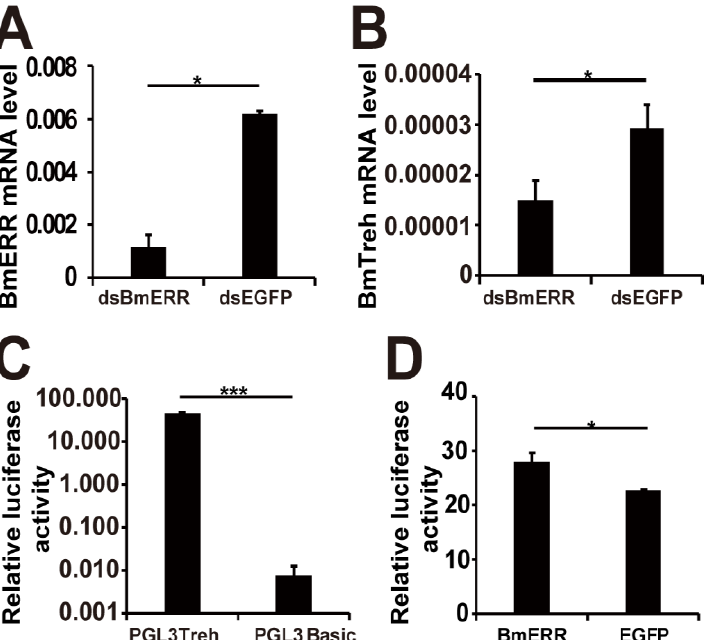
Figure 2. The expression of BmTreh is upregulated by BmERR in BmE cells. ( A , B ) BmTreh was downregulated by the RNAi of BmERR. qRT-PCR analysis of BmERR and BmTreh mRNA in dsBmERR treated cells; ( C ) Relative luciferase activity of the BmTreh promoter in BmE cells. ( D ) BmERR promote the luciferase activity driven by the promoter of BmTreh. The data represent means ± standard deviations ( n = 3). The significance of the differences between data sets was calculated using two- tailed Student’s t -tests; * p < 0.05. *** p < 0.001.